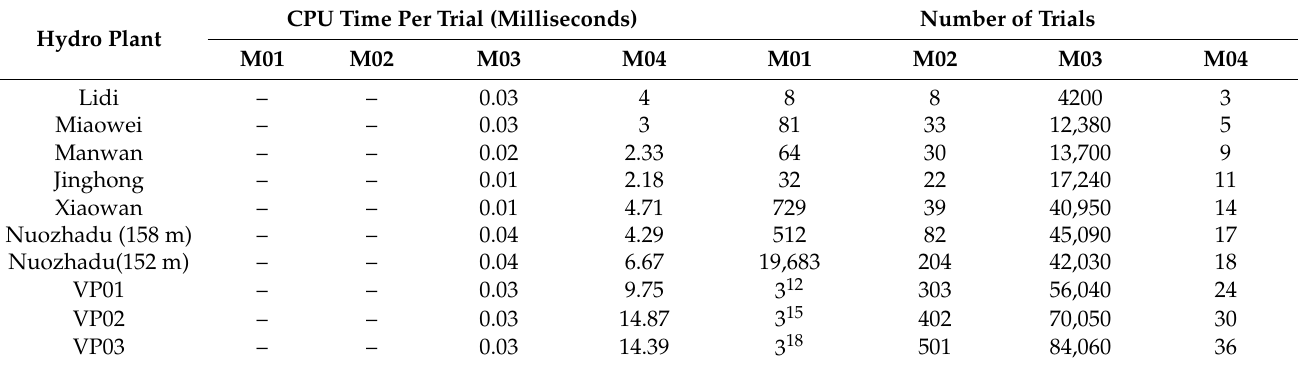
Table 4. The information behind the procedures that have different solution efficiency.